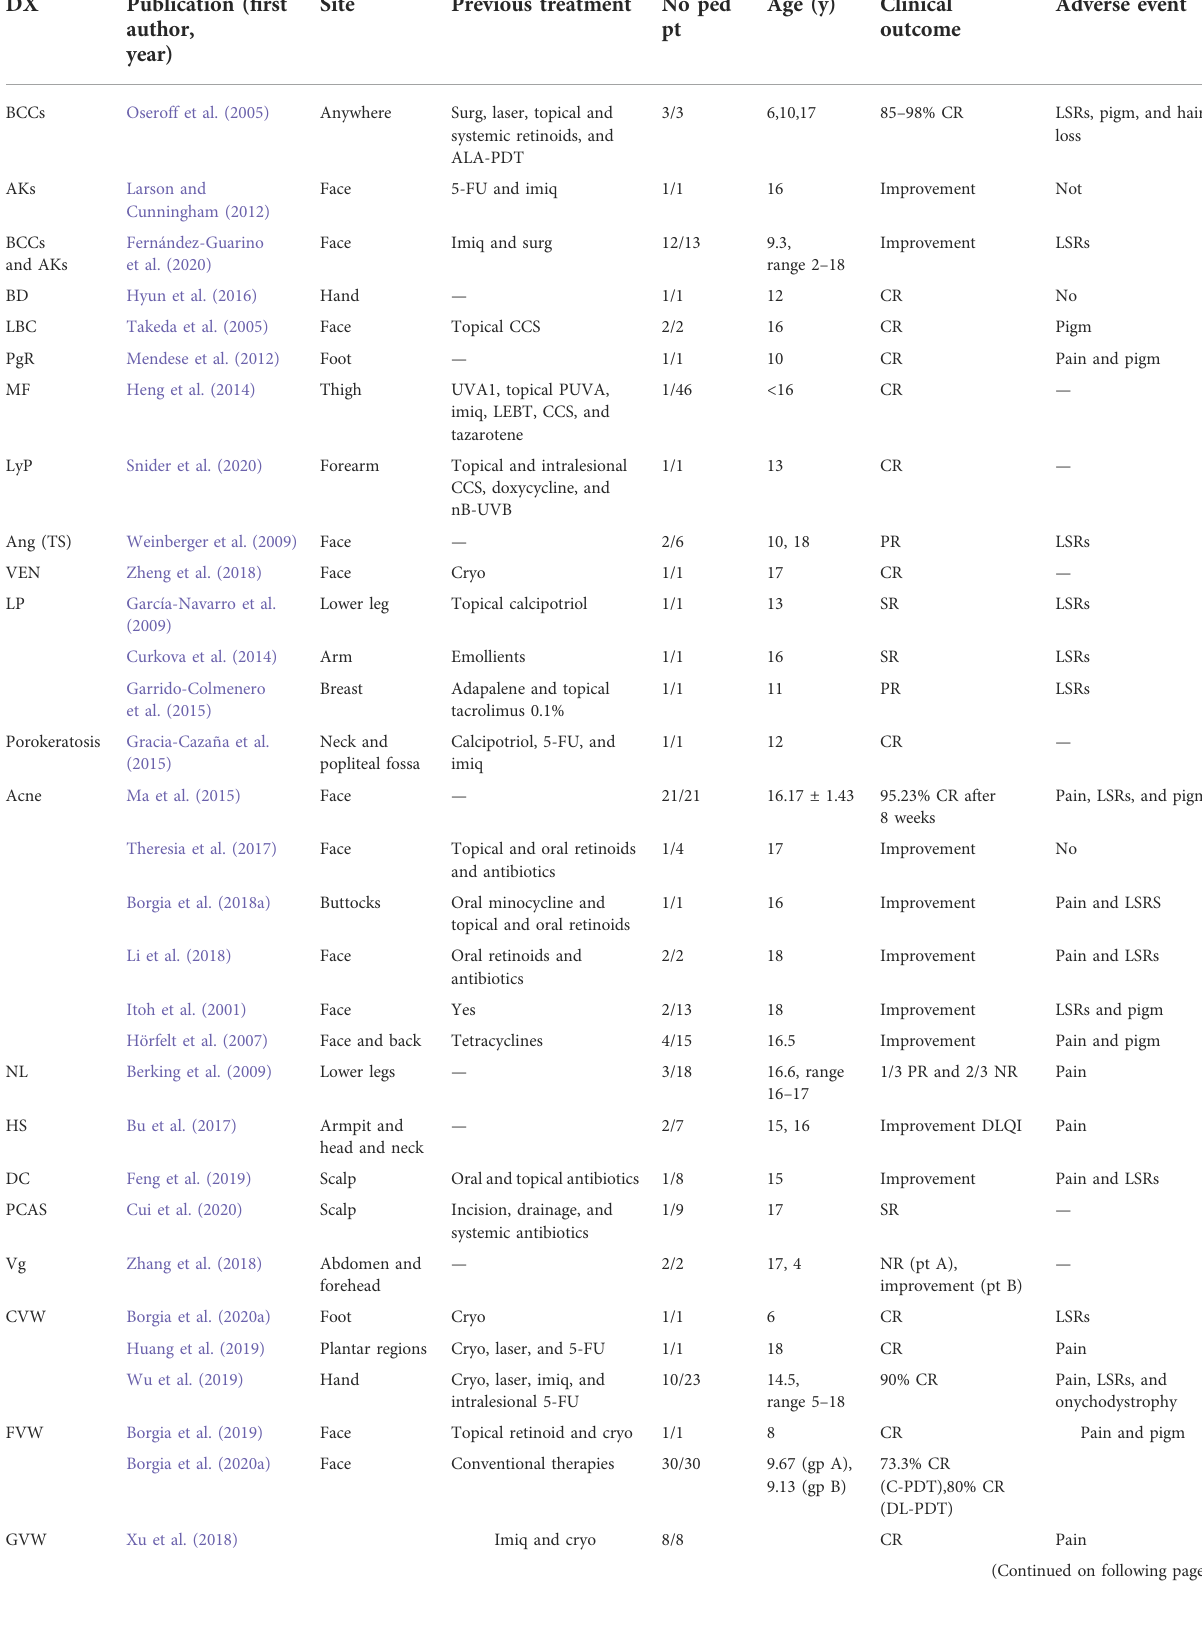
TABLE 1 Studies with speci fi c data on pediatric patients. Patients ’ age, clinical features, and PDT clinical